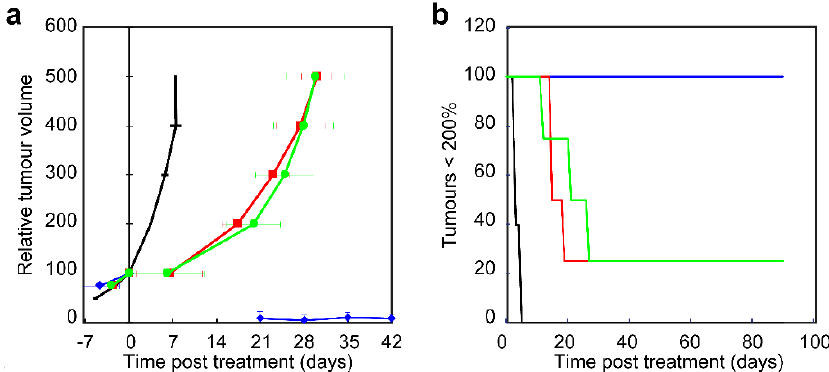
Figure 7. Effect of PDT using different fluence rates on the growth of OSC-19-luc2-cGFP tumor. ( a ) Relative tumor volume in time after treatment with control (black), 20 mW · cm − 2 (blue diamonds), 50 mW · cm − 2 (red squares), and 150 mW · cm − 2 (green circles). ( b ) Kaplan–Meier plot of the percentage of tumors that didn’t grow to more than 200% of the treatment volume after treatment with control (black), 20 mW · cm − 2 (blue), 50 mW · cm − 2 (red), and 150 mW · cm − 2 (green).